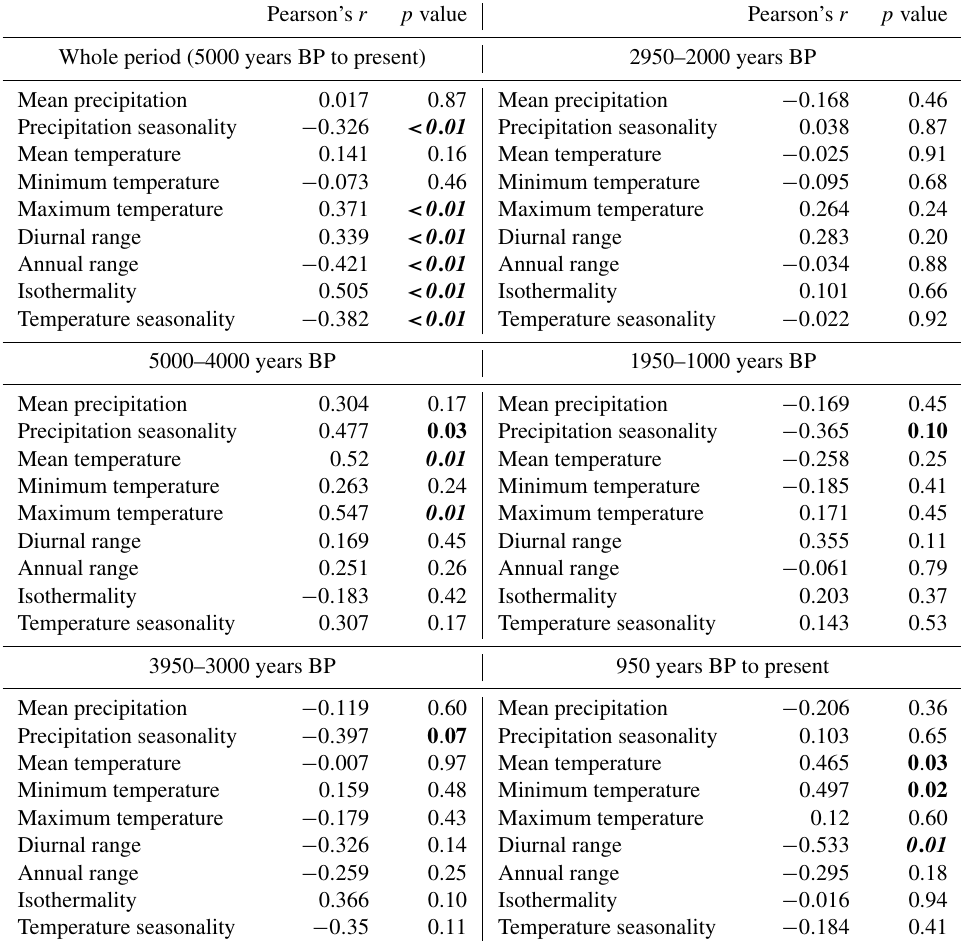
Table 3. Correlation coefficients and p values between the bioclimatic parameters of climate change and the reconstructed carbon accumu- lation rates, for a selection of time periods. The p values significant at the 0.05 level are highlighted in bold, whereas those significant at the 0.01 level are